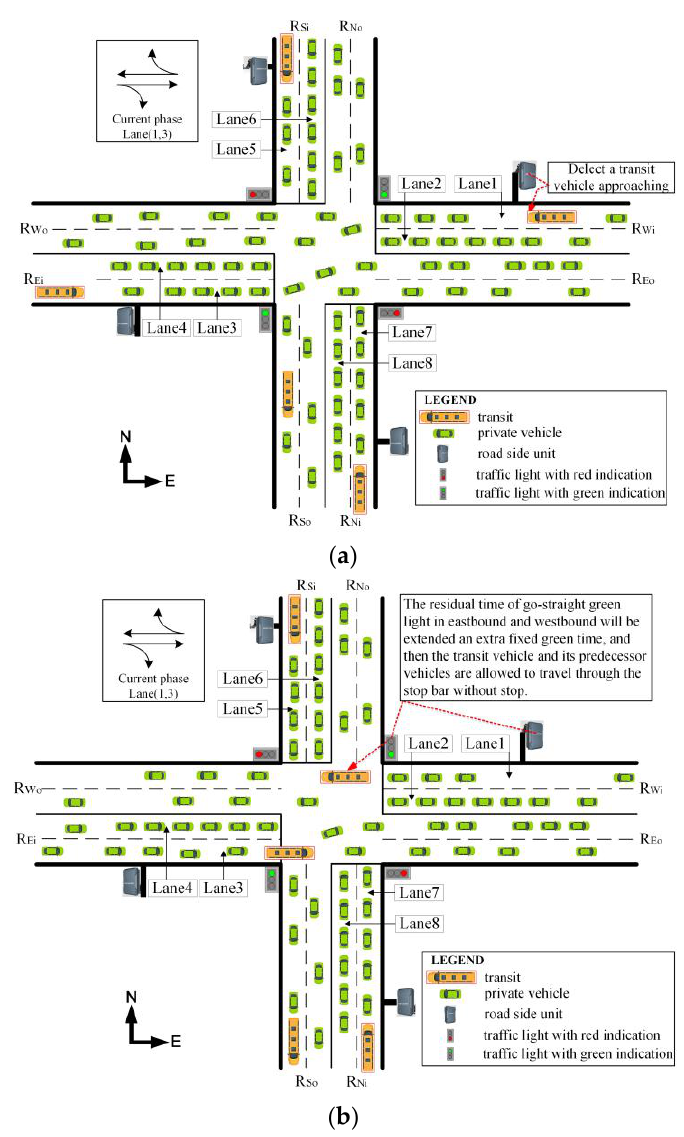
Figure 1. An example of intersection with the transit signal priority (TSP) control systems. ( a ) Before the priority strategy is applied; ( b ) After the priority strategy is applied.